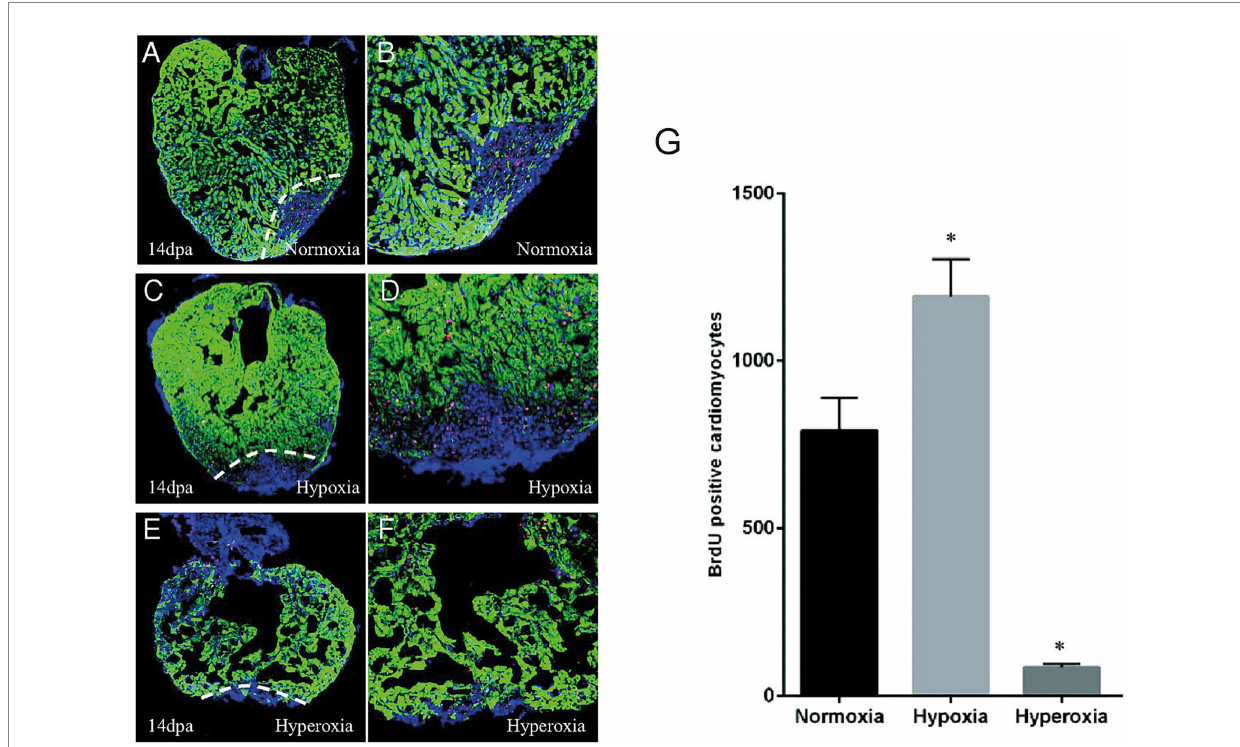
FIGURE 2 Hypoxia stimulates cardiomyocyte proliferation after injury in zebrafish. A-F. 14 dpa immunofluorescent staining under normoxic conditions (A,B) , hypoxia (C,D) or hyperoxia (E,F) and showing α -sarcomeric actin (green), BrdU (5-bromo-2 ′ -deoxyuridine) (red) and DAPI (blue). (G) The number of BrdU-positive proliferating cardiomyocytes increased in hypoxic conditions while it decreased in normoxic conditions. Adapted from Jopling et al.